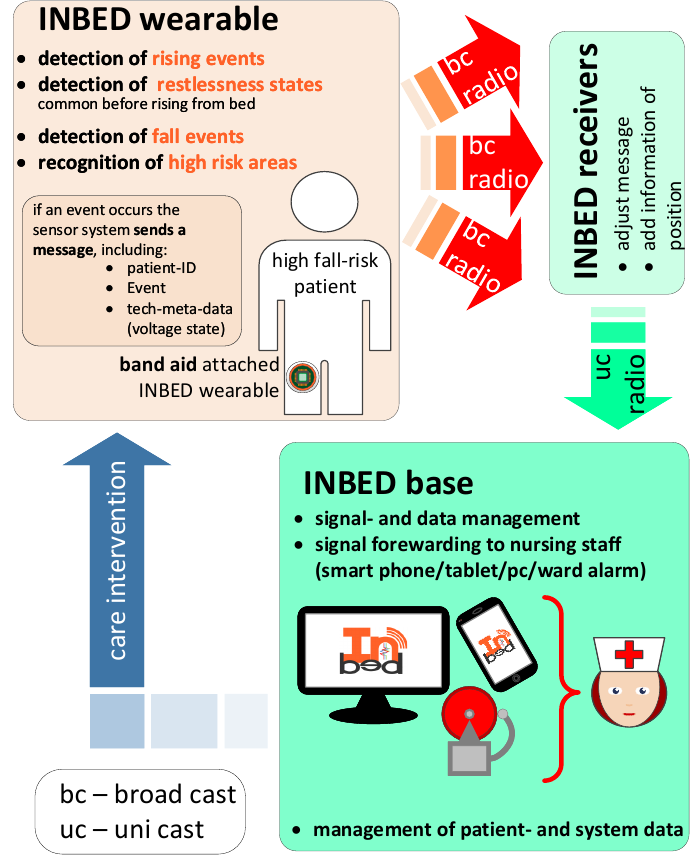
Figure 1. INBED system functionality